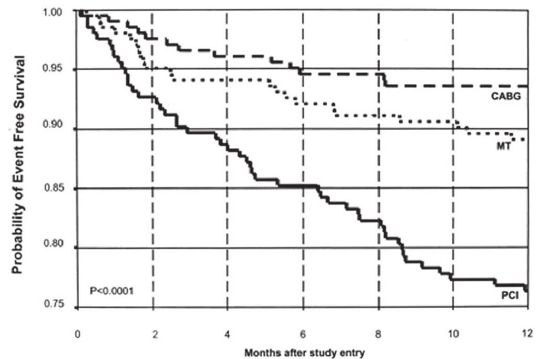
Fig. 2 – Sobrevivência livre de reintervenções, ao final de (MT) – Figura extraída da referência 15, com autorização da Revista.